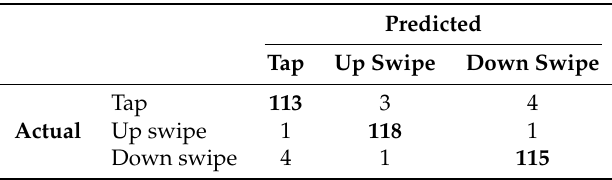
Table 2. Confusion matrix of classified